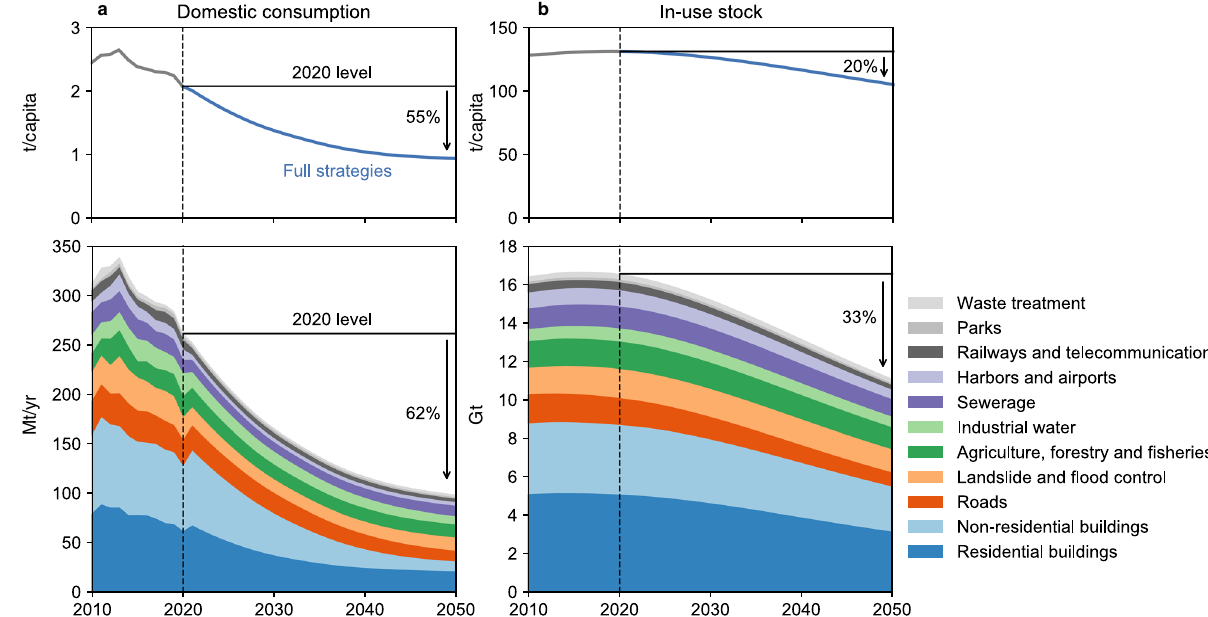
Fig. 5 Domestic consumption and in-use stocks of concrete with and without a set of supply- and demand-side strategies in Japan, 2010 – 2050. a Domestic consumption. b In-use stock. The top panel shows per capita values, while the bottom panel shows the total values. The vertical dashed lines mark the year in which the future scenario analyses begin